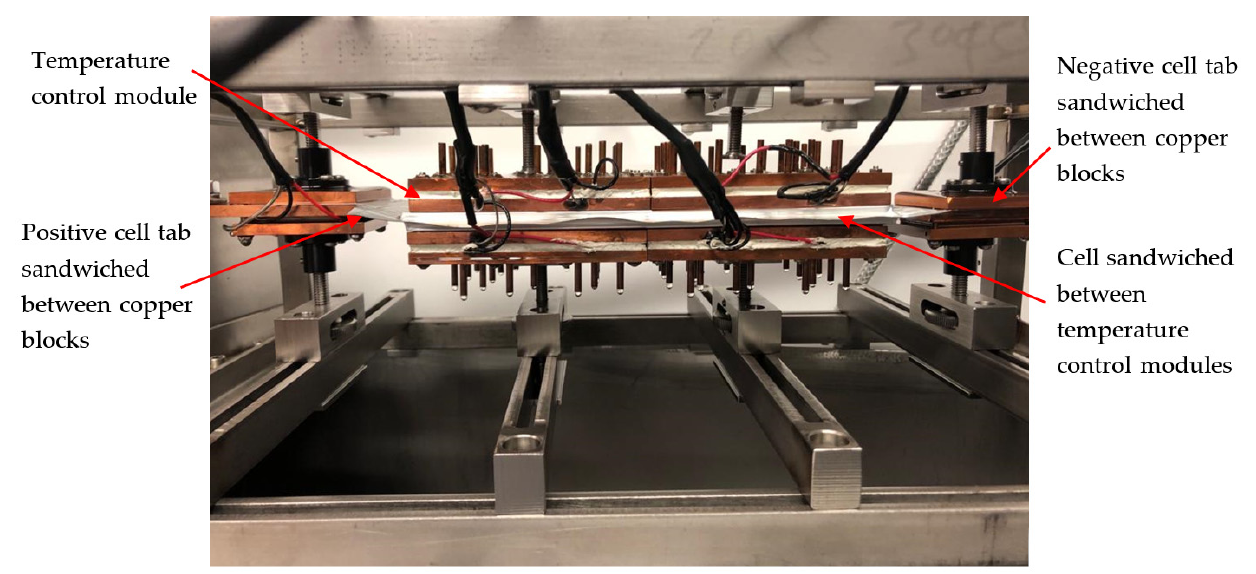
Figure 3. Isothermal control platform (ICP) using Peltier elements to control cell temperature with conductive heat transfer through metallic blocks.